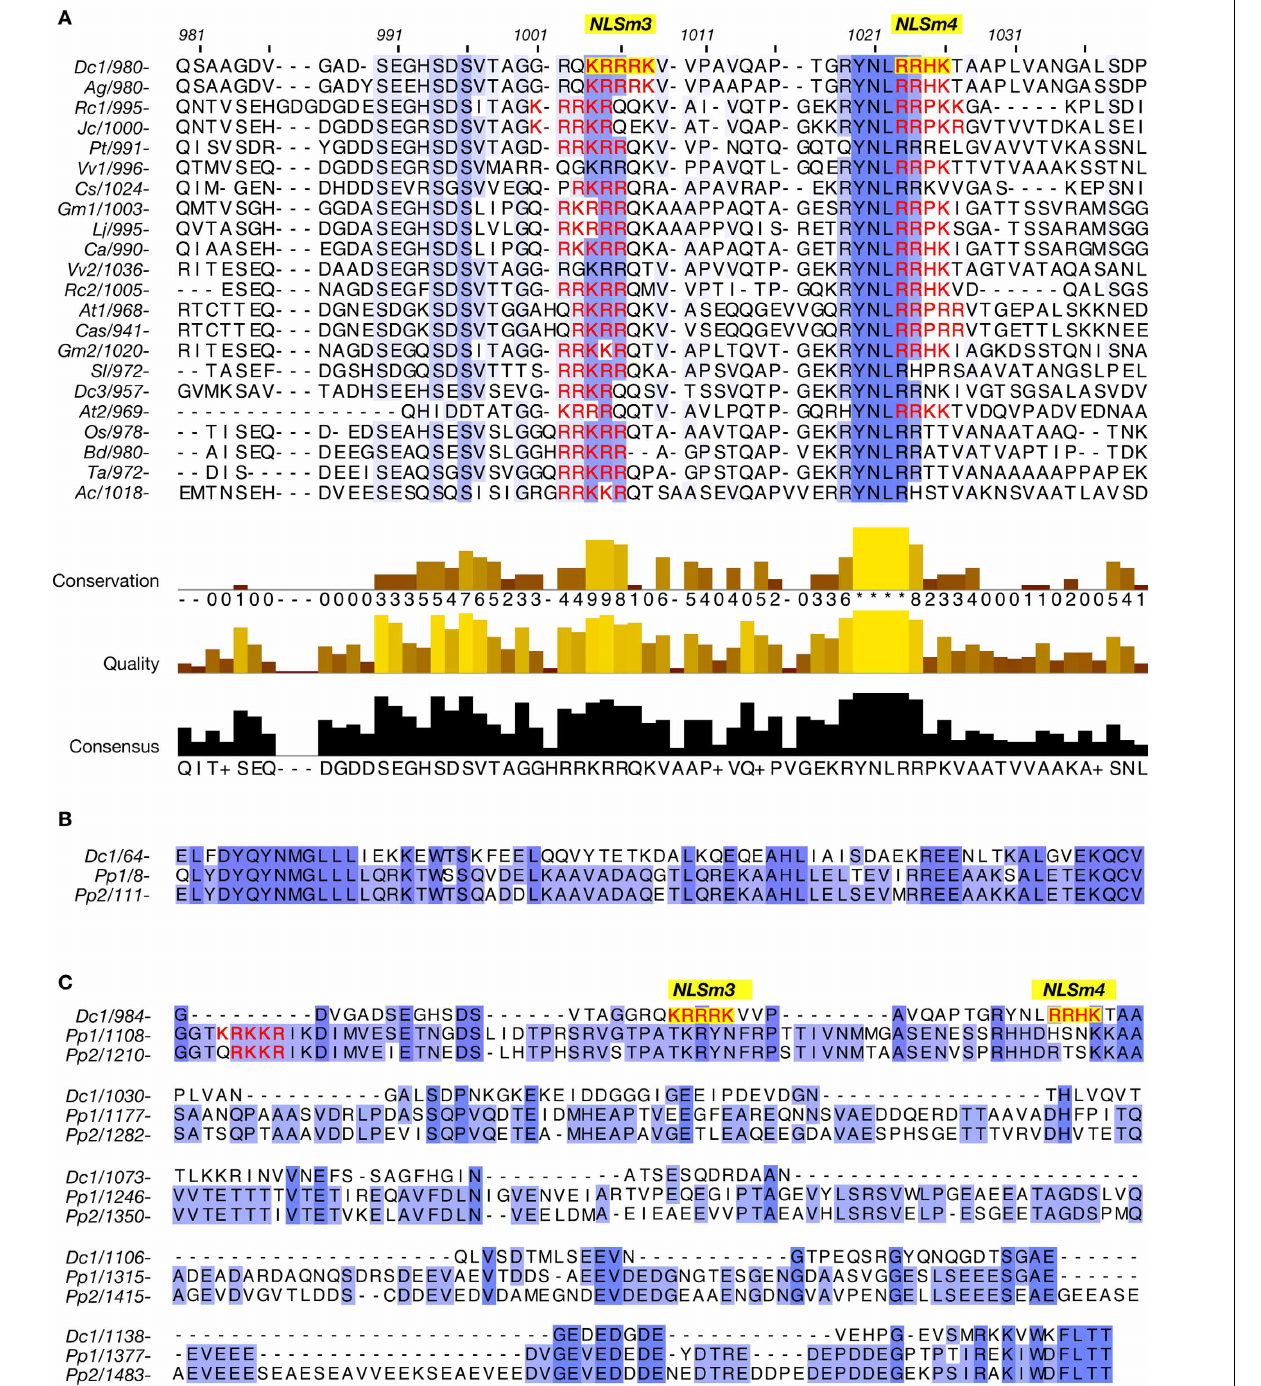
species: Dc1 (NMCP1) and Dc3 (NMCP3) ( Daucus carota ), Ag ( Apium graveolens ), Cs ( Cucumis sativus ), At1 (LINC1) and At2 (LINC2) ( Arabidopsis thaliana ), Rc1 and Rc2 ( Ricinus communis ), Gm1 and Gm2 ( Glycine max ), Lj ( Lotus japonicus ), Jc ( Jatropha curcas ), Ca ( Cicer arietinum ), Cas ( Camelina sativa ), Sl ( Solanum lycopersicum ), Pt (P opulus trichocarpa ), Vv1 and Vv2 ( Vitis vinifera ), Os ( Oryza sativa ), Bd sequences are listed in Supplemental table